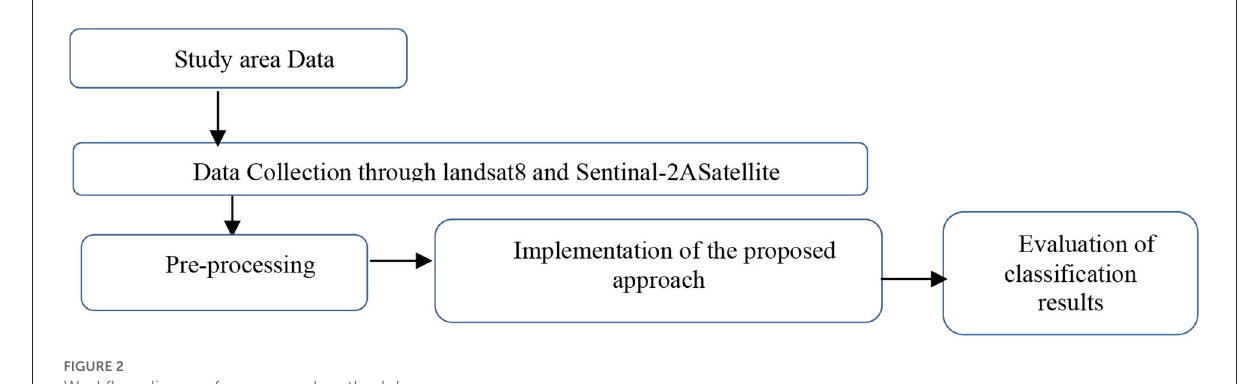
FIGURE2 Workflow diagram for proposed methodology.